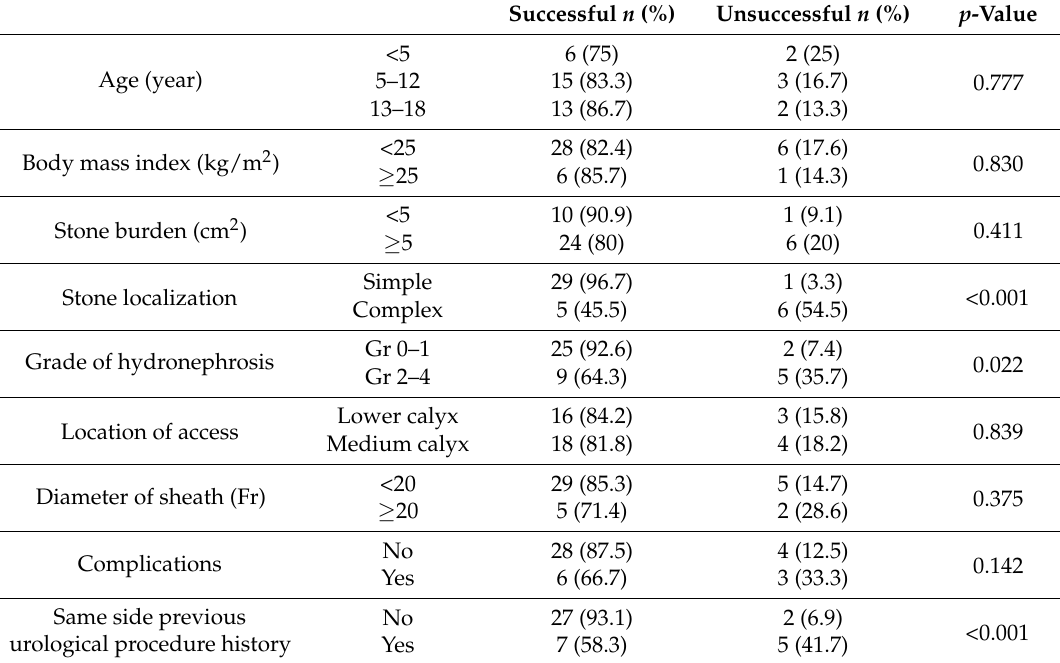
Table 4. Factors affecting the success of percutaneous